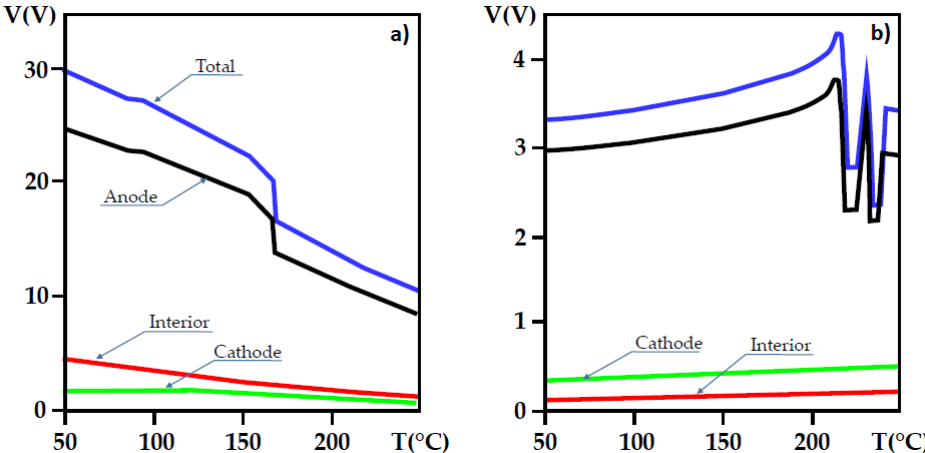
Figure 51. Temperature dependence of the potential drop along the electrodegraded Fe:SrTiO 3 crystal for constant current polarization. The measurements have been obtained for different electrodegradation (electro-coloration) times ( a ) t = 20 h; ( b ) t = 80 h. Adapted from [58].